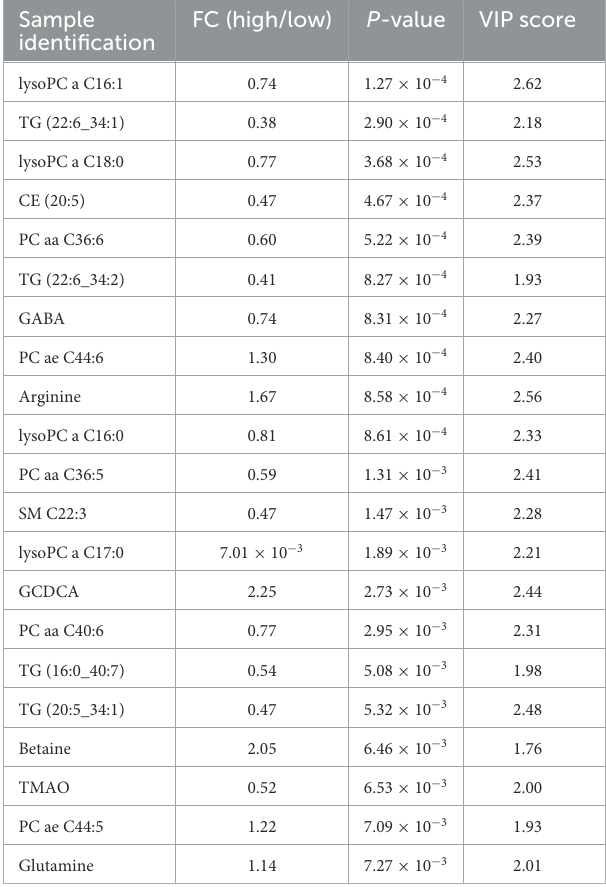
TABLE 2 Twenty-one differential metabolites in the two